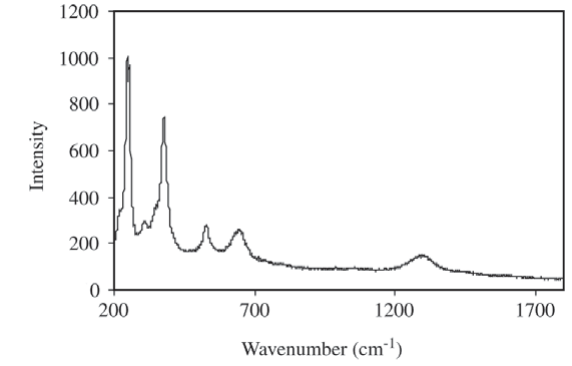
Figure 1. Raman spectrum of a carbon steel specimen exposed at Alto da Serra site, for three months, showing characteristic peaks of lepidocrocite from red oxide region.